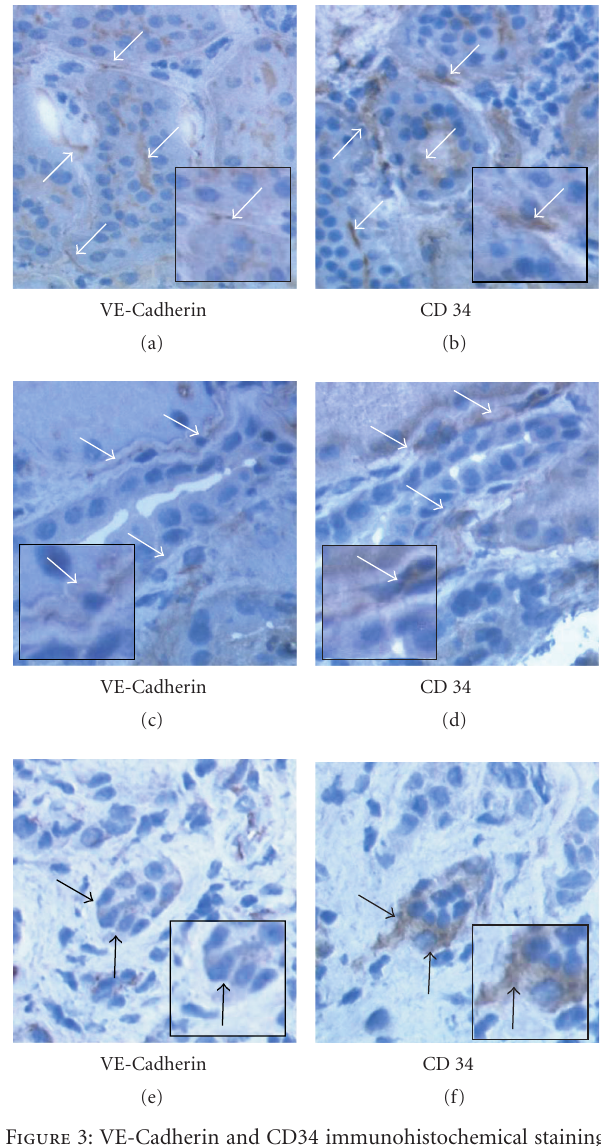
Figure 3: VE-Cadherin and CD34 immunohistochemical staining of frozen renal biopsy serial sections (X 400). (a), (b) No acute rejec- tion. (c), (d) Acute rejection grade IA. (e), (f) Acute rejection grade IIA. (a), (c) and (e): VE-Cadherin staining on peritubular endothe- lial cells (arrows). (b), (d) and (f): CD34 staining on peritubular endothelial cells